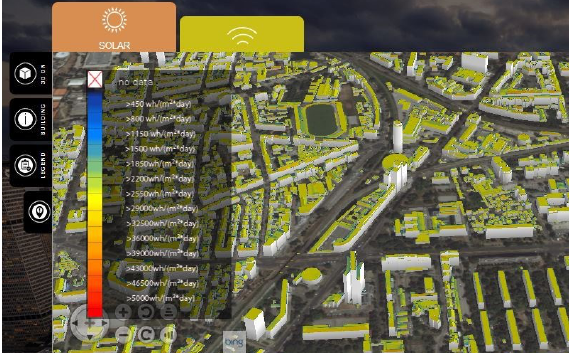
Figure 3. Platform containing available information about solar energy potential at building level